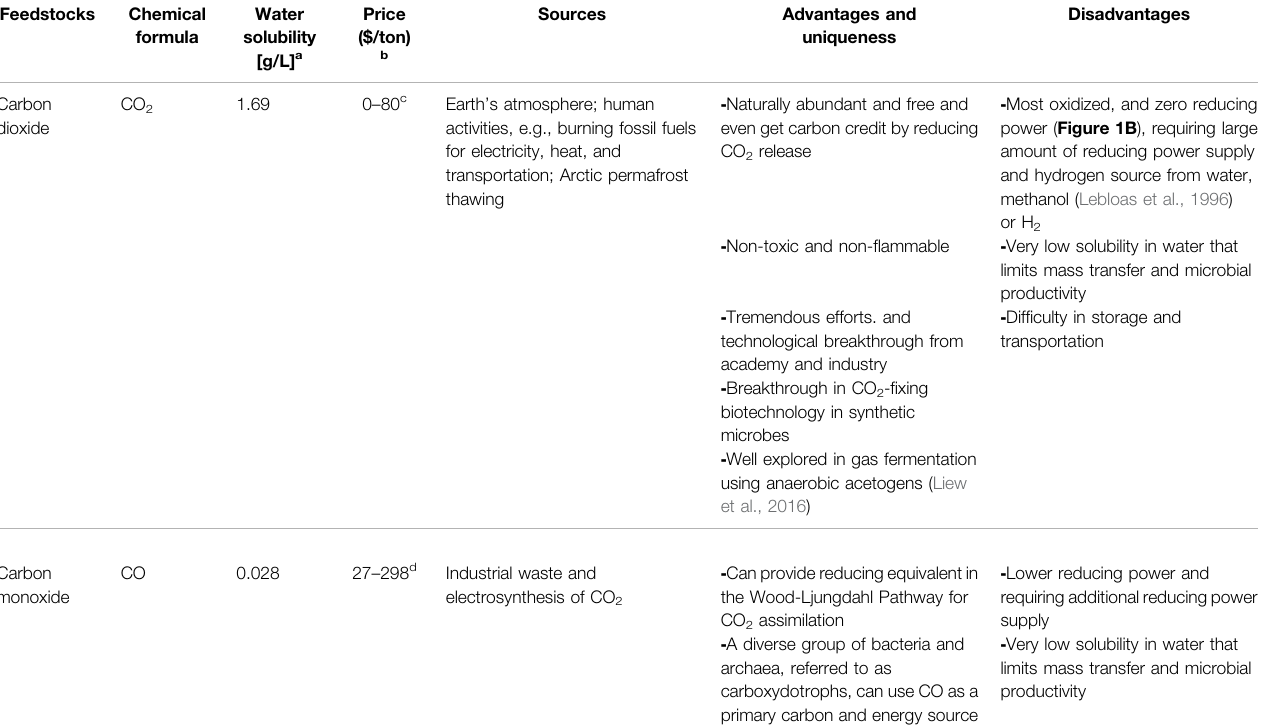
TABLE 1 | Advantages and disadvantages of various next-generation feedstocks (NGSs) and